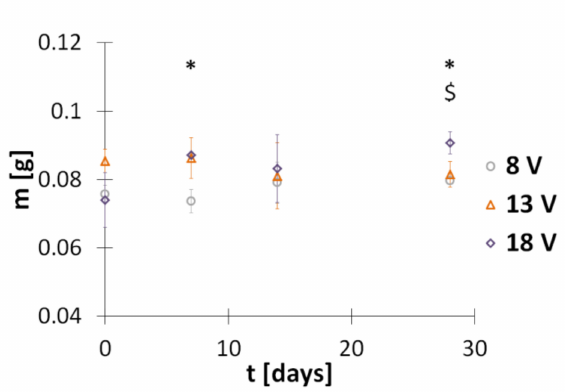
Figure 7. Mass of hybrid implants incubated in PBS (pH 7.4) at 37 ◦ C for specified periods. * and $ indicate significant differences between groups of implants obtained in electrodeposition at 8 V and 18 V ( p < 0.05), and 13 V and 18 V ( p < 0.05),